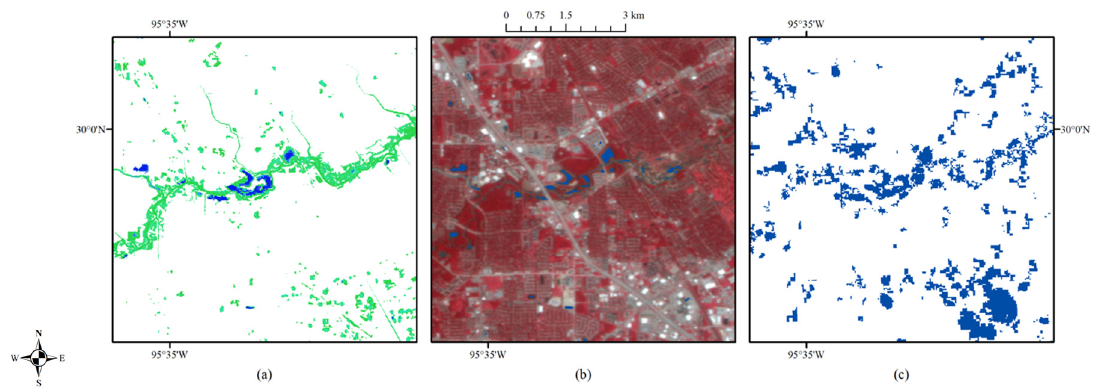
Figure 13. Enlarged site (C): inundation probability ( a ), the corresponding optical image on 1 September ( b ), and ( c ) FEMA flood map, with water shown in blue.